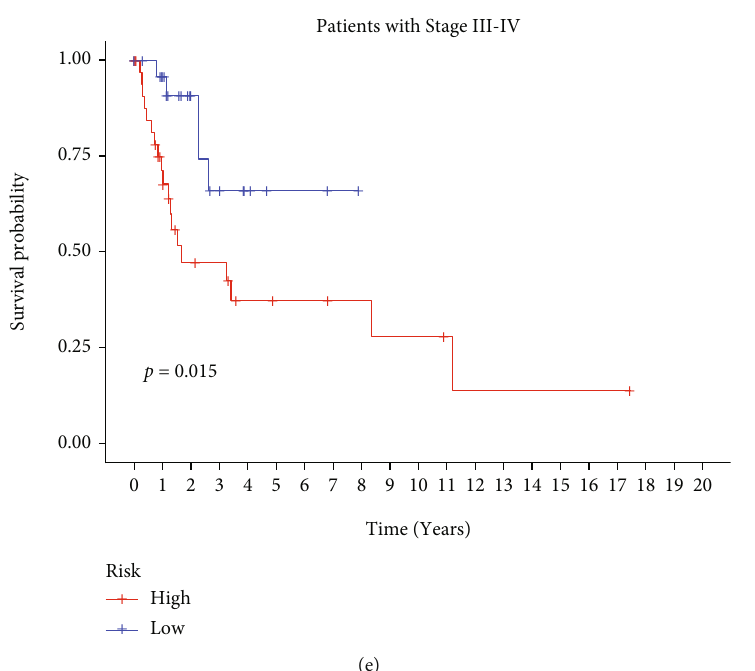
Figure 5: Survival analysis of clinically relevant factors. (a – e) Age ( < 65), grade (G1-G2, G2-G3), and stage (stage I-II, stage III-IV) K-M survival curves of high- and low-risk